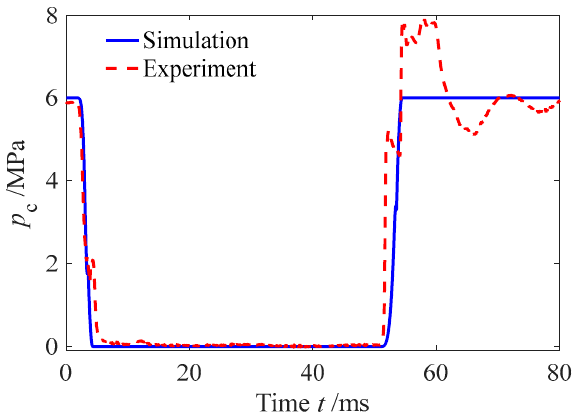
Figure 7. Comparison of simulation and experiment.